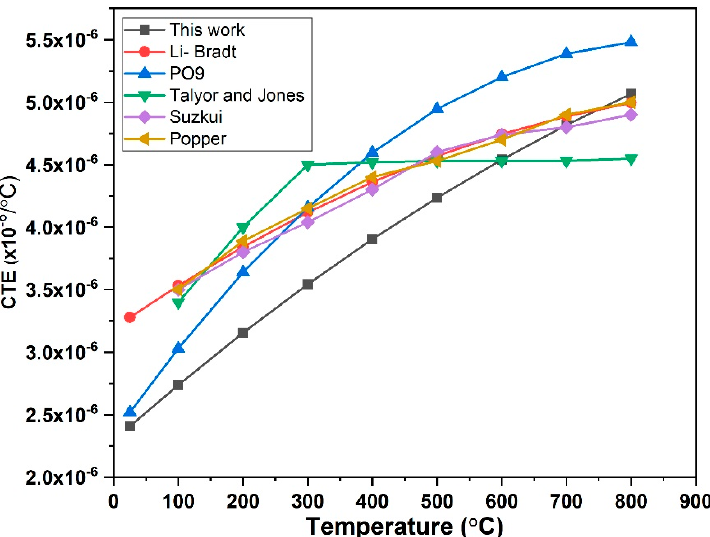
Figure 10. Illustrates the variation of the thermal expansion coefficient of